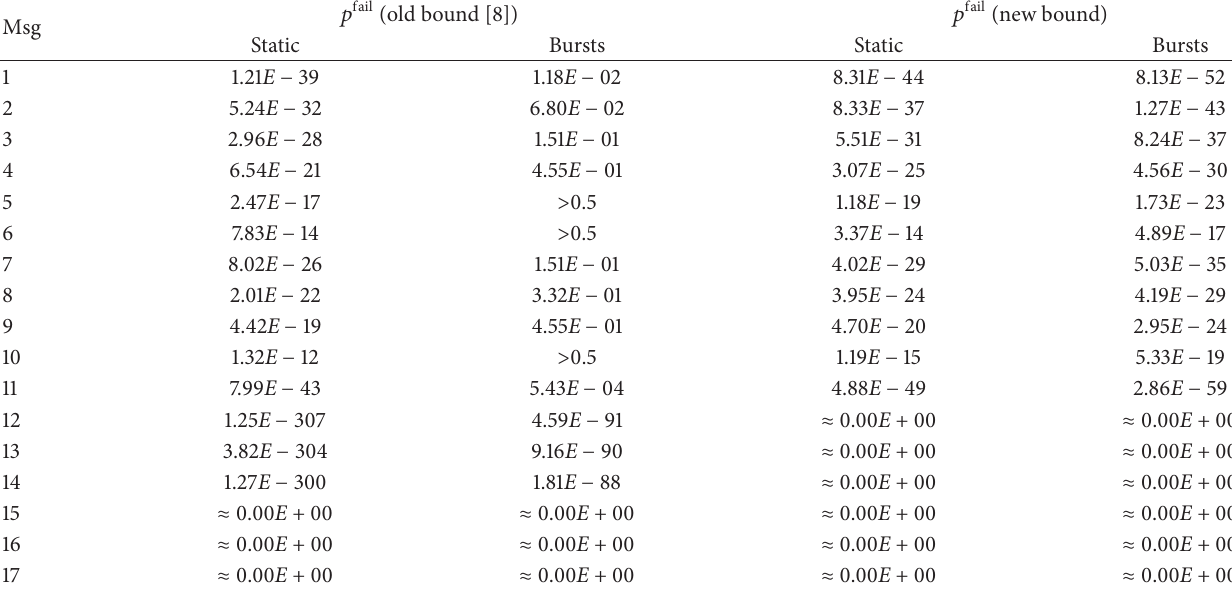
Table 3: Deadline failure probabilities for static and bursty